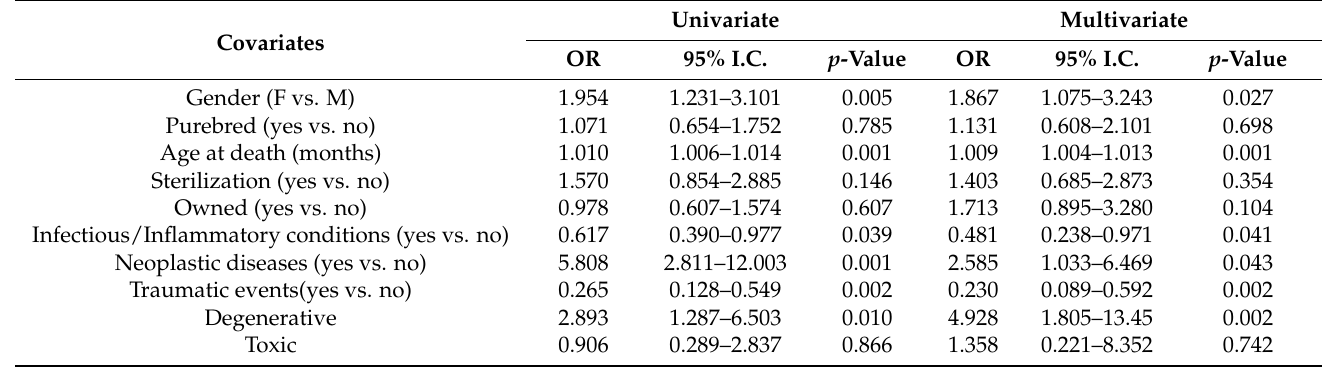
Table 2. Results of univariate and multivariate logistic regression analysis for gender, purebred, age at death, sterilization, owned, and PPs as risk factors associated with “Euthanasia yes or no”.